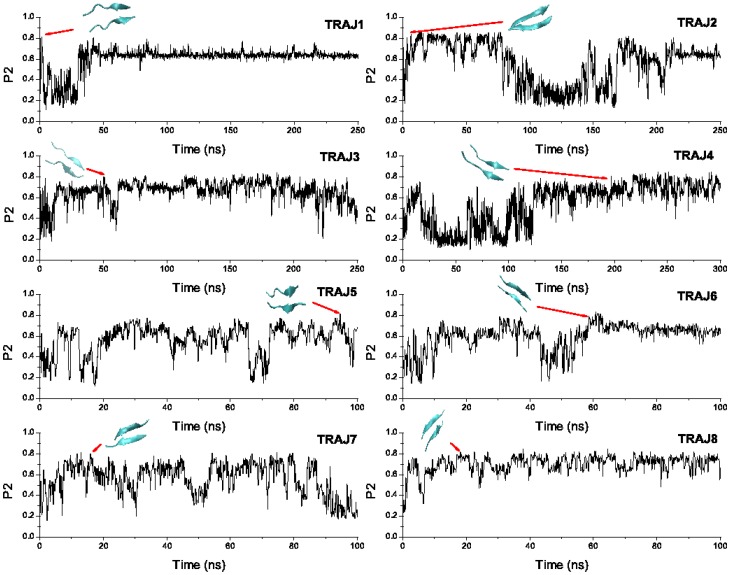
Time dependence of order parameter  for LVEALYL dimer.The order parameter  has been calculated using the definition of Nguyen et al [31]. Fibril structures are formed at 1.6, 6.0, 50.4, 196.7, 94.6, 60.6, 15.9, and 18.1 ns for run 1, 2, 3, 4, 5, 6, 7, and 8, respectively.